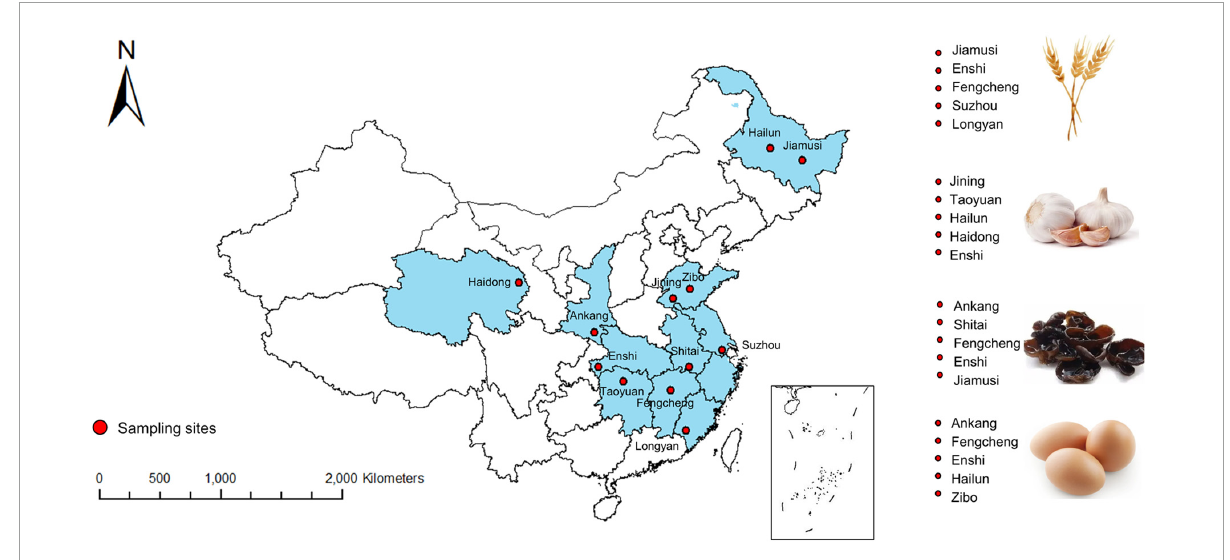
FIGURE1 Distribution of sampling